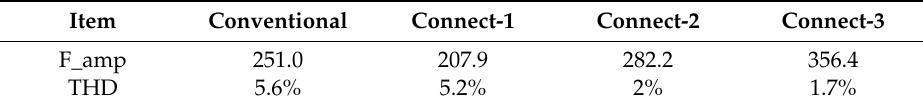
Table 4. Main parameters of the in-wheel motor.